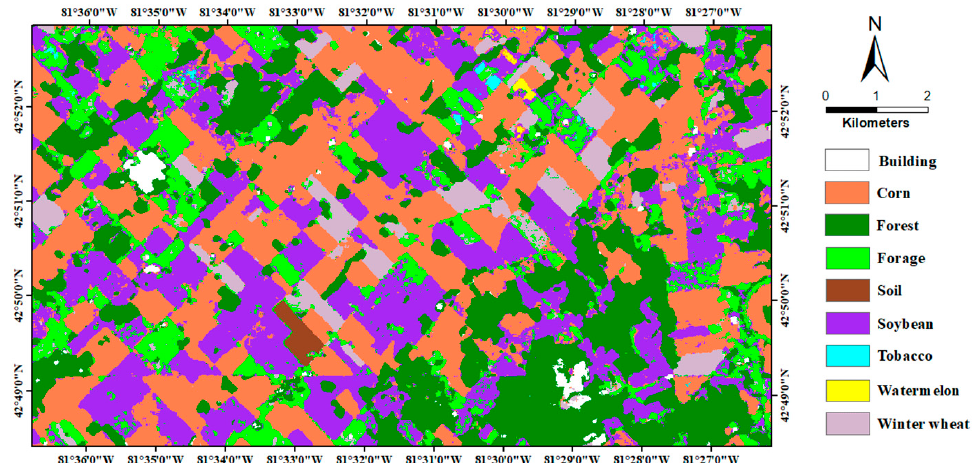
Figure 11. Classification map with the best accuracy using an optimal combination of polarimetric observables from all RADARSAT-2 images (OA = 93.75%).